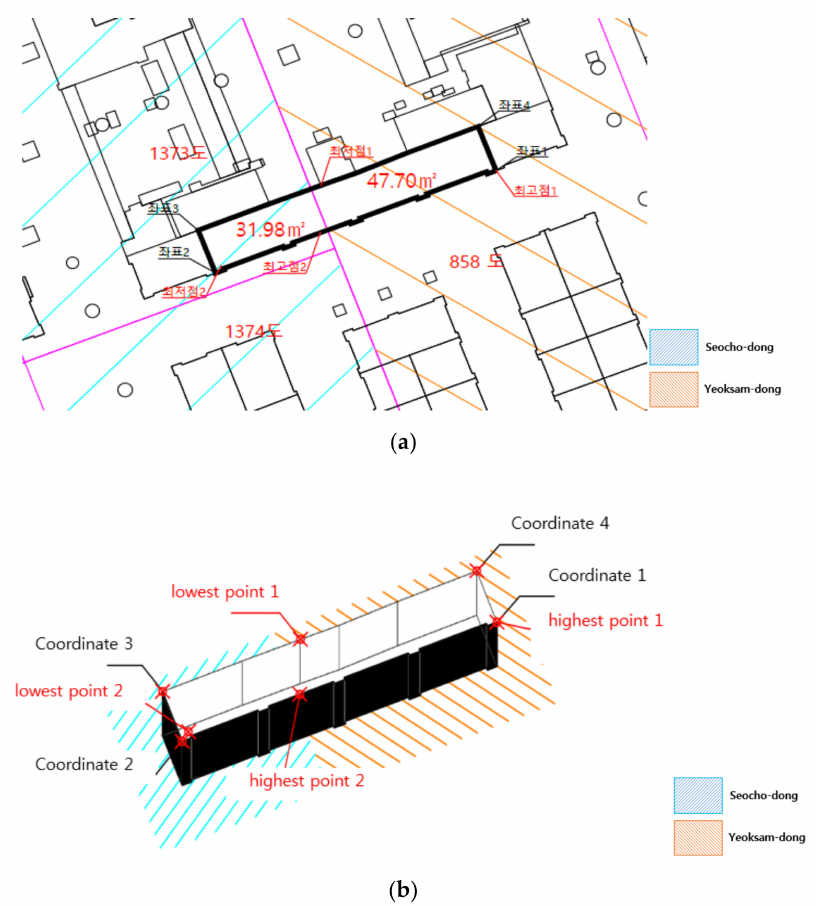
Figure 8. Generating vertical location status information with above-ground parcels. ( a ) Located under different above-ground parcels. ( b ) Highest and lowest points for each